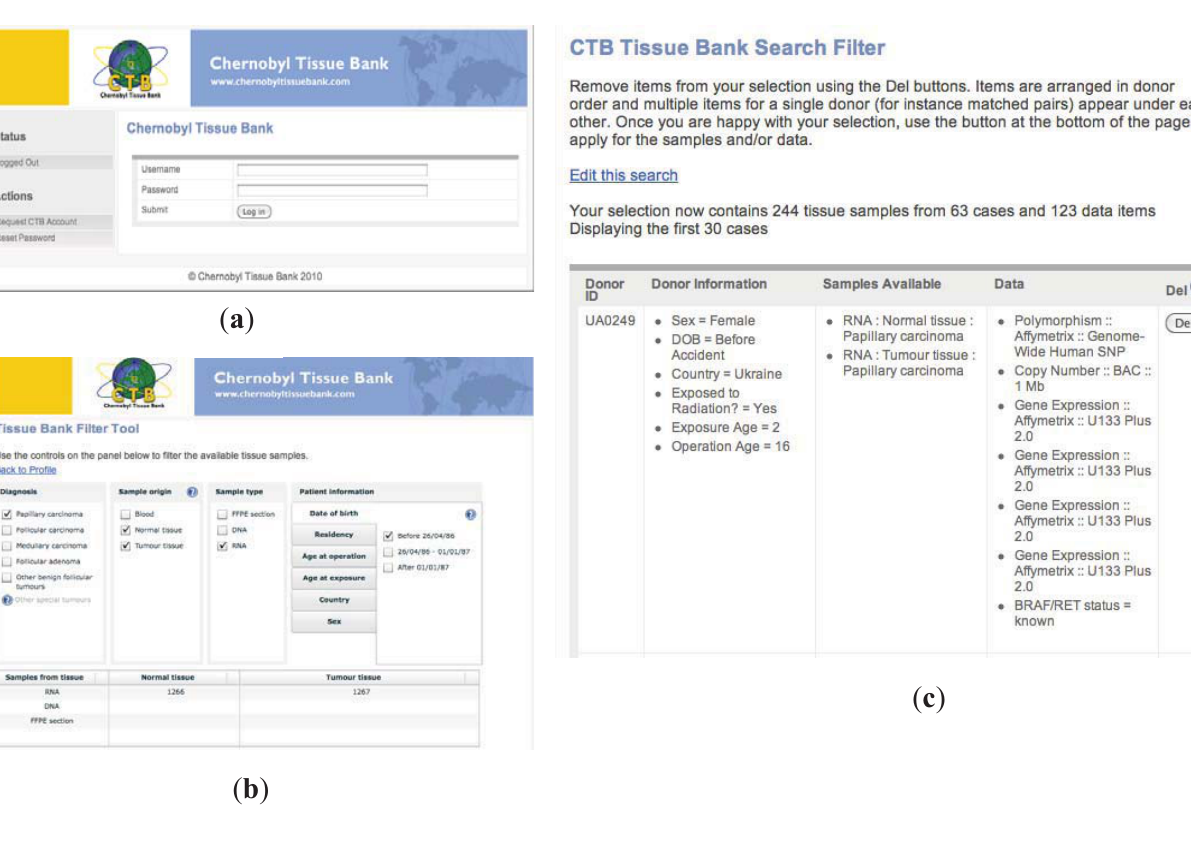
Figure 3. Representative screen shots of the CTB portal. ( a ). login entry page; ( b ). user searches samples by selecting criteria of interest. As search filters are selected, numbers of samples matching criteria are shown; ( c ). representative search results page showing available samples, search criteria and additional data available for